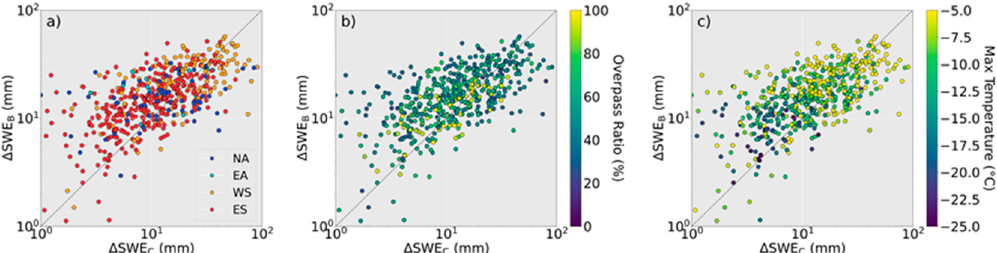
Figure 6. Collocated ∆ SWE measurements for 10 ◦ × 5 ◦ grid cells at one month resolution, as in Figure 5, but colored with respect to region ( a ), overpass ratio ( b ), and maximum temperature ( c ).